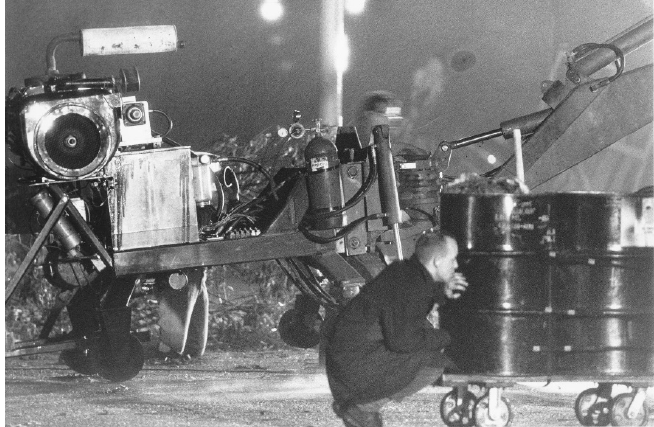
Figure 15. Scene from Misfortunes of Desire: Acted Out at an Imaginary Location Symbolizing Everything Worth Having , a mechanical performance by SRL, 17 May 1988, parking lot of Shea Stadium, Queens, New York. © Survival Research Labs.